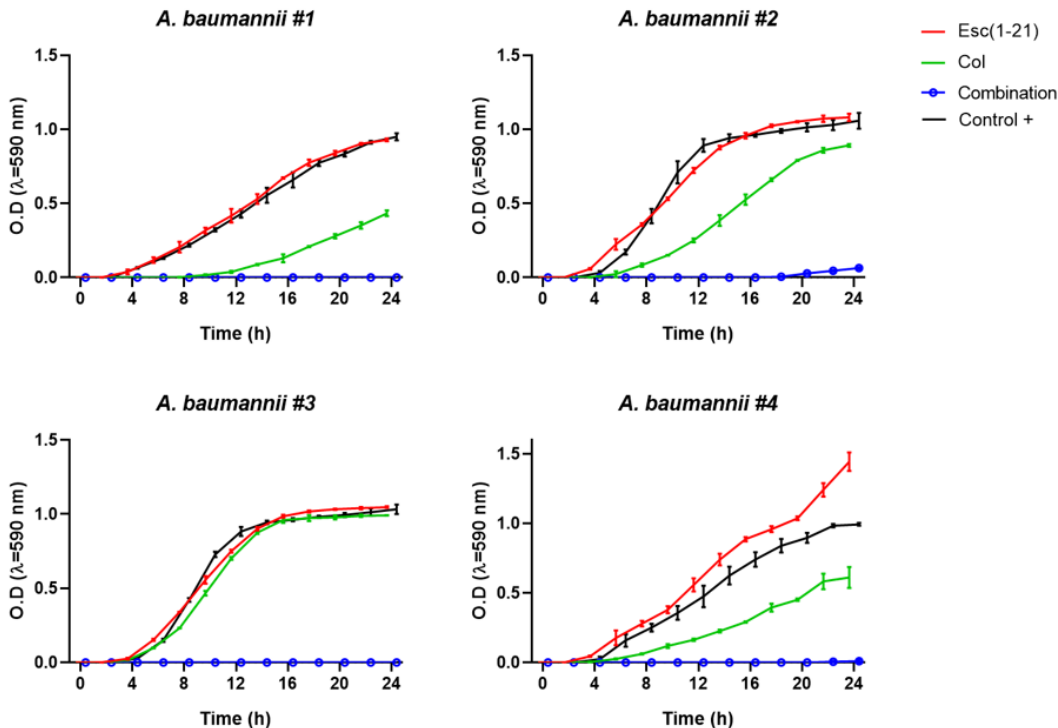
Figure 1. Growth profiles for the #1, #2, #3, and #4 A. baumannii strains treated with colistin (Col), Esc(1-21), or their combination at the MIC FIC. Untreated control samples were included for compar- ison. Results are of the mean ± standard deviation (SD) of three independent experiments.